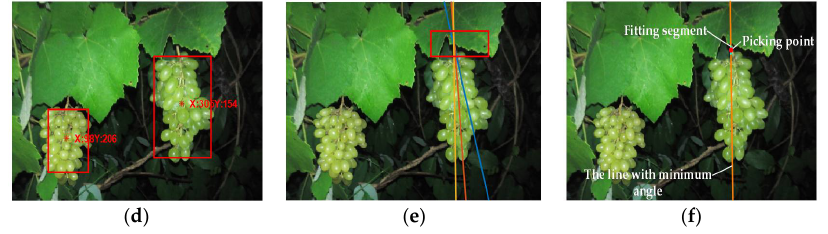
Figure 10. The successful detection results. ( a , d ) Fruit area; ( b , e ) the region of interest (red box) and the Hough detection; ( c , f ) picking-point calculation. Table 2. Statistical results of grape-detection experiment.